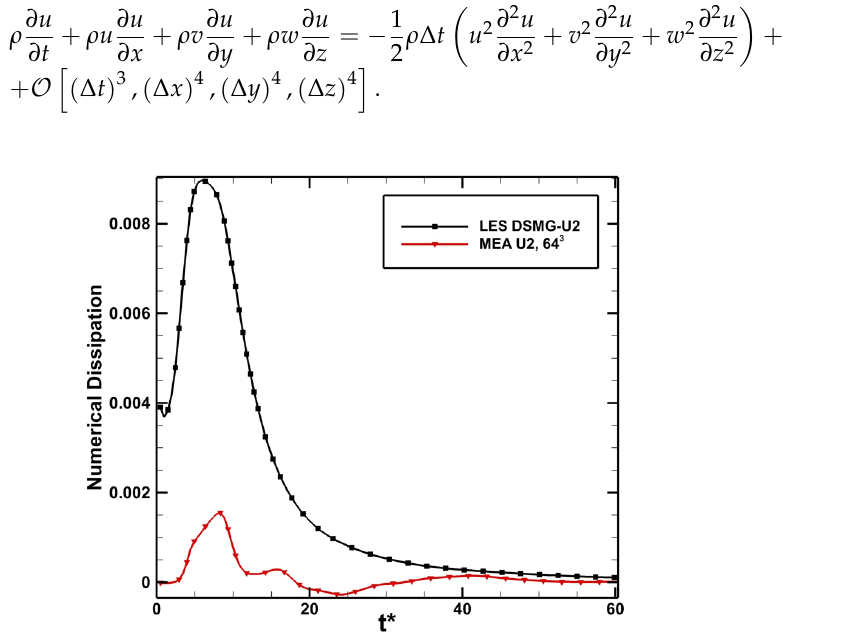
Figure 7. Contribution of second-order partial derivatives in the truncation error of the second-order upwind scheme obtained using Modified Equation Analysis (MEA) on a 64 3 mesh and compared to the kinetic energy dissipation rate obtained using DSMG-U2 on the same